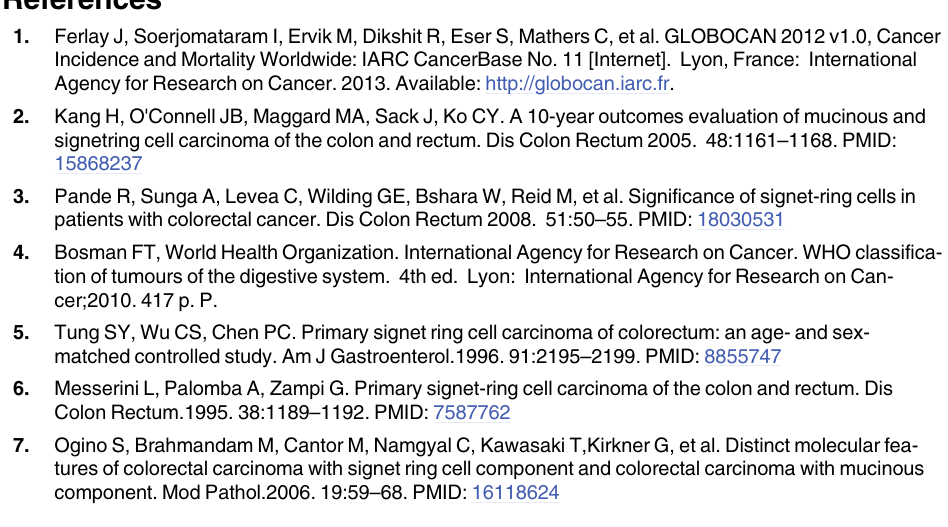
S1 Table. Pathogenic mutations found in patients ’ tumors by NGS and their nucleotide changes associated with germline mutations reported from literatures. S2 Table. Multigene Mutation Profiling by NGS. N = the number of